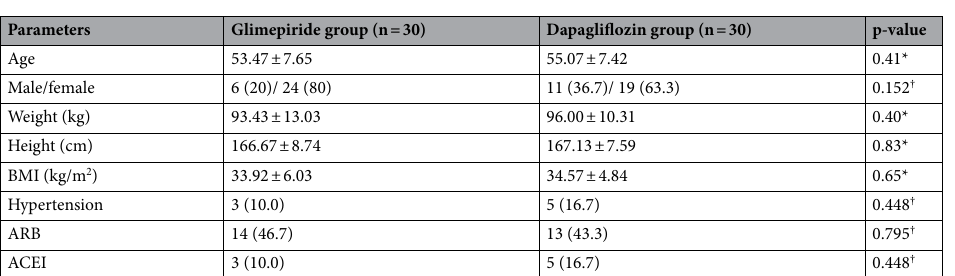
Table 1. Baseline characteristics of patients participated in the study. Data are presented as mean ± SD or number (percentage). Data are analyzed using independent sample t-test or chi-square test as appropriate. The significance level was set at p < 0.05. BMI body mass index, ARB angiotensin receptor blocker, ACEI angiotensin-converting enzyme inhibitor. *Independent sample t-test. † Chi-square (X 2 ) test.